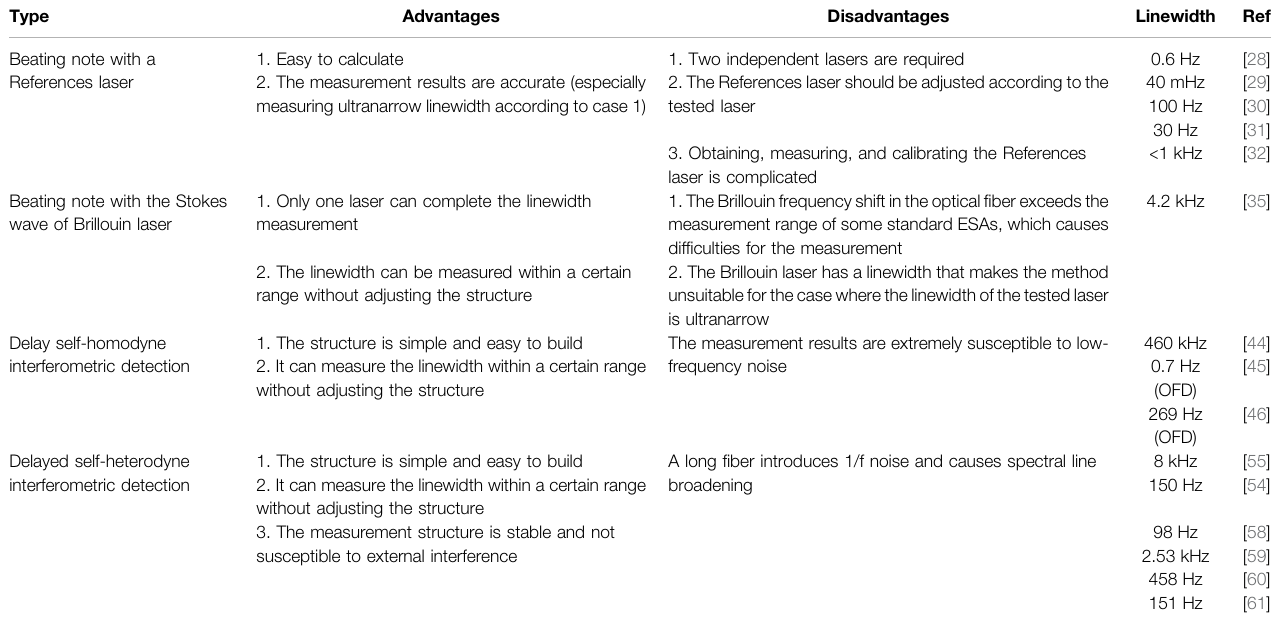
TABLE 1 | Comparison of laser linewidth measurement